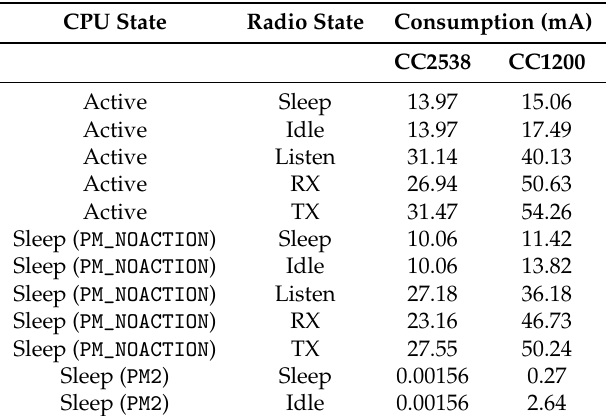
Table 15. Current drawn during different device